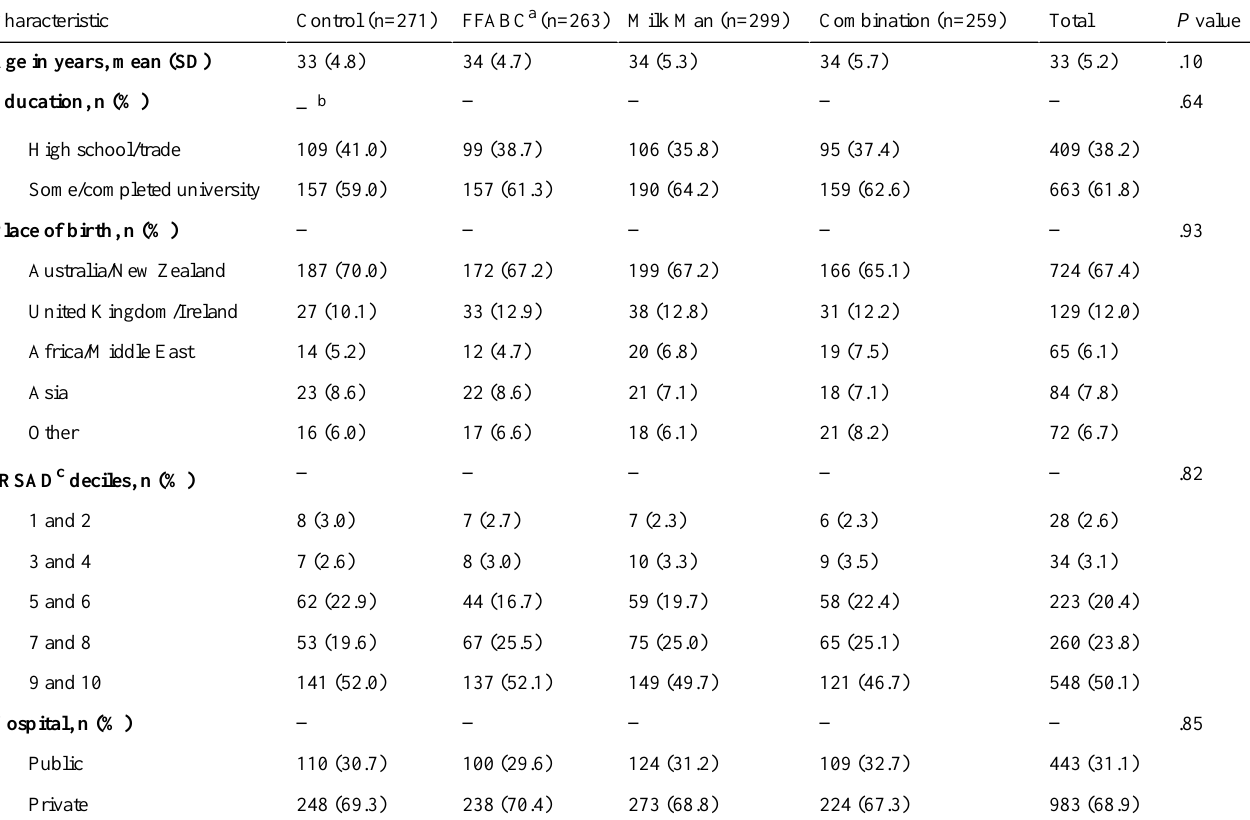
Table 1. Baseline characteristics of participating fathers by intervention group